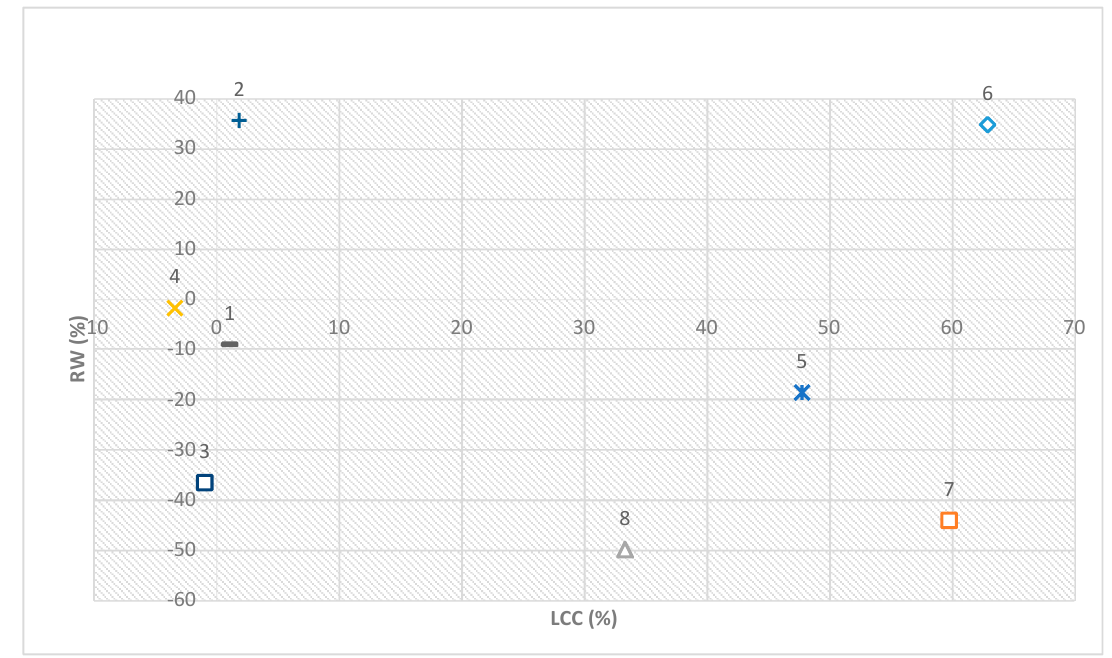
Figure 7. Radioactive waste disposed against life cycle costs.